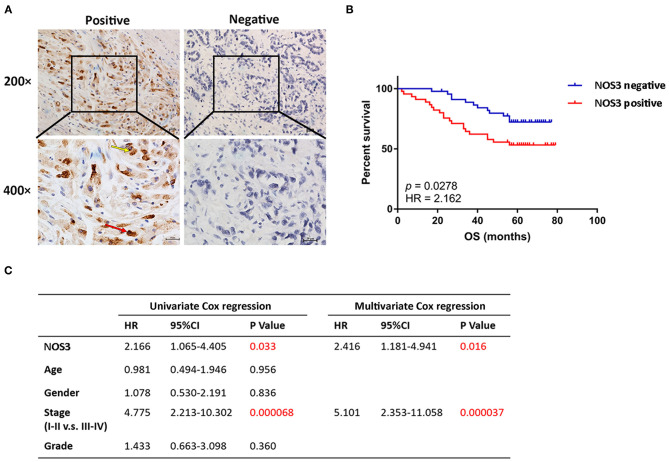
NOS3 was independent prognostic factor of patients with gastric cancer. (A) Representative images of positive and negative NOS3 protein expression in gastric cancer tissues. NOS3 was expressed in cytoplasm (yellow arrow) and nucleus (red arrow) of tumor cells. There were 45 patients stained positive and 45 patients stained negative. The scales bars indicate 20 μm. (B) Kaplan-Meier analysis of NOS3 protein in gastric cancer patients. Patients with higher NOS3 expression had shorter OS compared with patients with lower NOS3 expression (p = 0.0278, HR = 2.162). (C) Univariate and multivariate cox regression showed that higher NOS3 protein expression and advanced pathological stage were independent prognostic factor in gastric cancer patients.